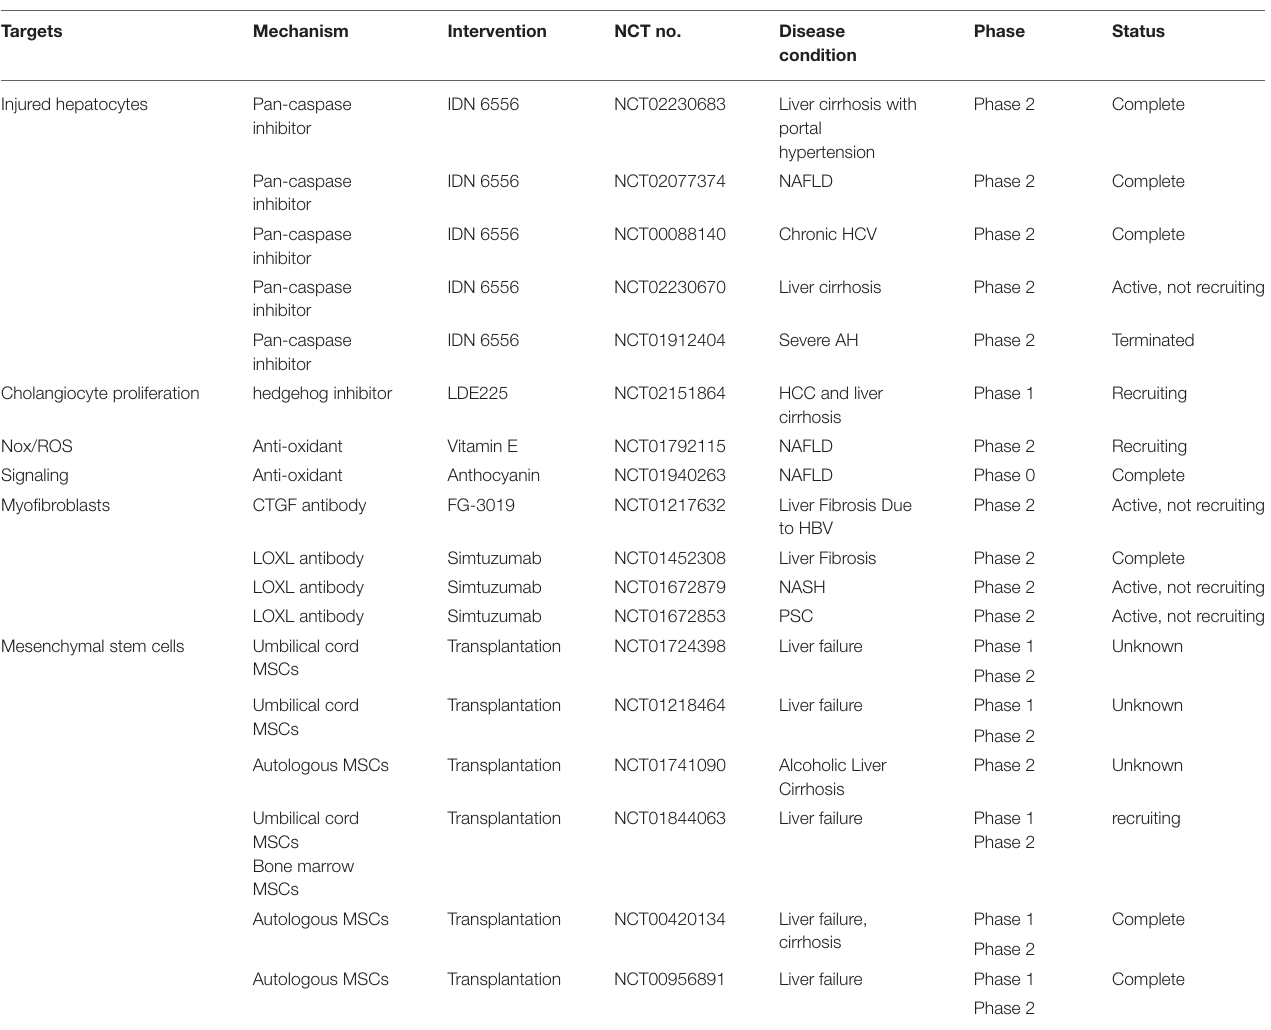
TABLE 2 | Ongoing clinical studies of antifibrotic